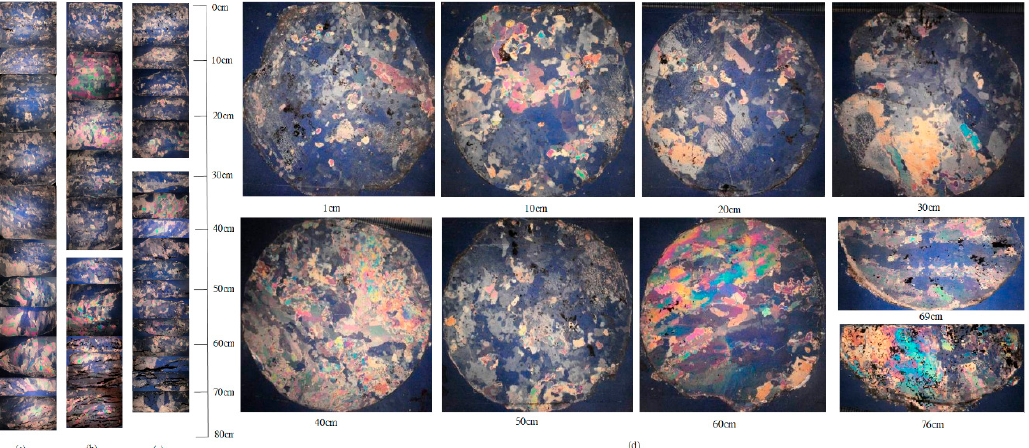
Figure 4. Ice microstructure at Point B in the Yellow River: ( a ) ice microstructure in the direction perpendicular to the ice surface (15th February); ( b ) ice microstructure in the direction perpendicular to the ice surface (24th February); ( c ) ice microstructure in the direction perpendicular to the ice surface (27th February); ( d ) ice microstructure of different ice layers parallel to the ice surface (24th February)